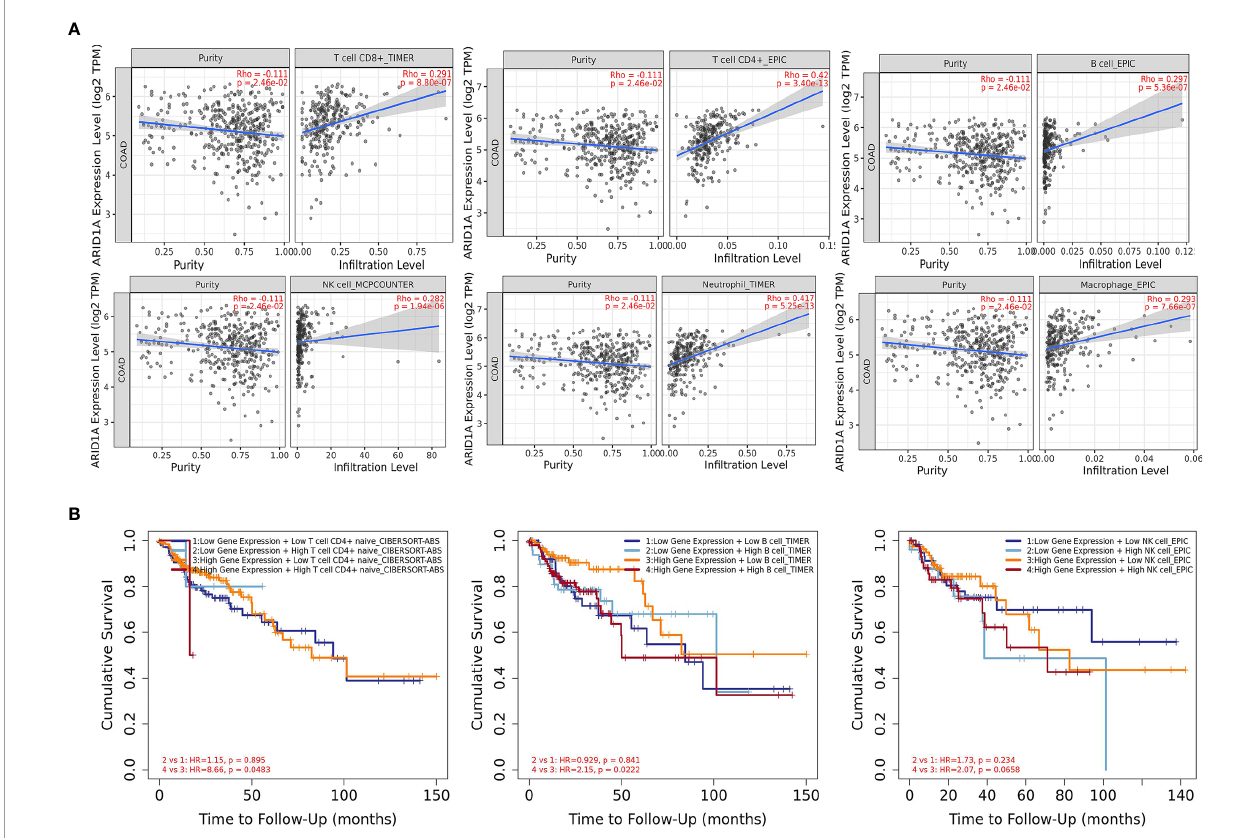
FIGURE 5 | The correlation between ARID1A and immune cell in fi ltration. (A) The signi fi cant positive correlation between ARID1A and subtypes of immune cells (TIMER); (B) Kaplan-Meier curves for the immune in fi ltrates and ARID1A Expression. The correlation between ARID1A expression and the abundance of CD4+ T cells, B cells, and natural killer cells, respectively